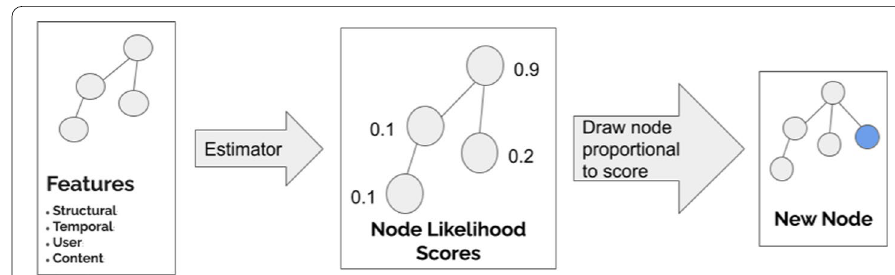
Fig. 4 Diagram illustrating how nodes are added to the tree